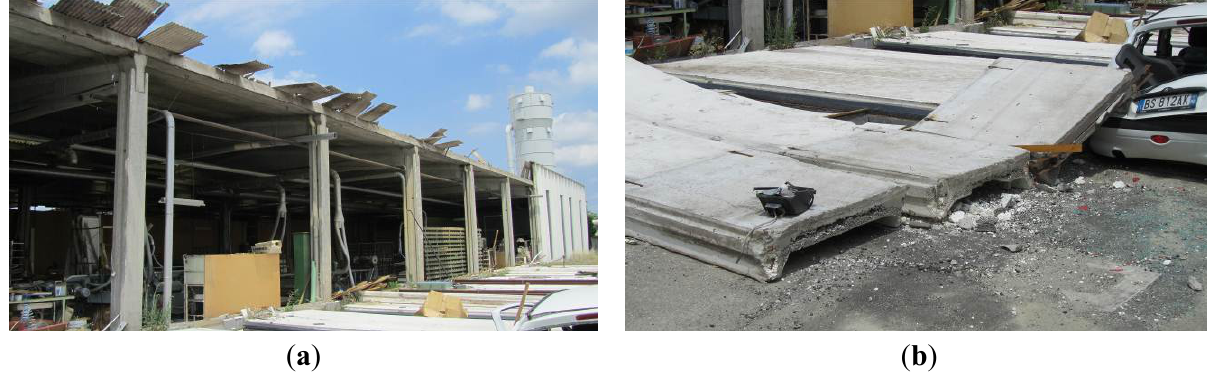
Figure 8. Connections between façade panels and RC structure: ( a ) Panel-to-edge beam connections; ( b ) Panel-to-ground beam